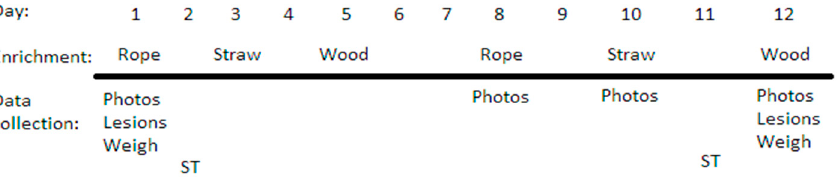
Figure 2. Timeline illustrating data collection and the rotation schedule for enrichments in Rotation and Stimulus treatments (ST). Each treatment lasted 12 days, followed by two days off. Four treat- ments were provided consecutively to each pen group in random order over a period of eight weeks (beginning at 5–6 weeks and ending at 13–14 weeks of gestation). Adapted from Roy et al. [10].